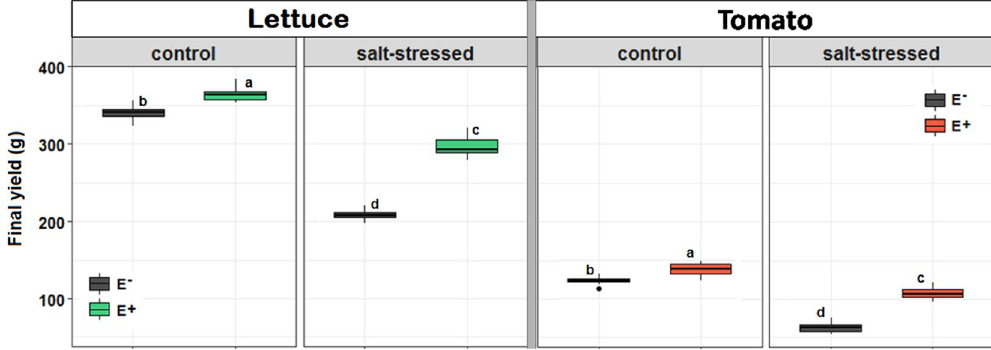
Figure 1. Effect of saline treatment (50 mM NaCl, control, vs. 150 mM NaCl, salt-stressed) and fungal inoculation (E − vs. E + ) on the final yield of lettuce (left) and tomato (right) at the end of the experiment. Different lowercase letters indicate, for each species separately, significant differences between treatments (Tukey HSD tests; α = 0.05). Values are means ± SD ( n = 25).